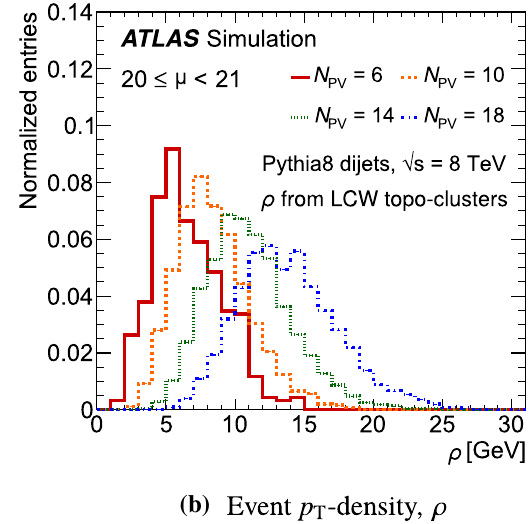
Fig. 3 a Ratio of the jet active area to π R 2 , where R is the jet radius parameter and b the event p T -density ρ . The jet area ratio is shown separately for R = 0 . 4 and R = 0 . 6 jets reconstructed with the anti- k t